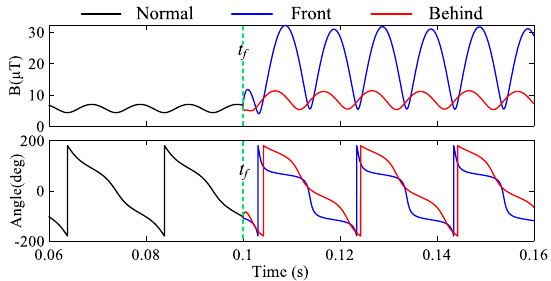
Fig. 21 Absolute value and phase of magnetic fields